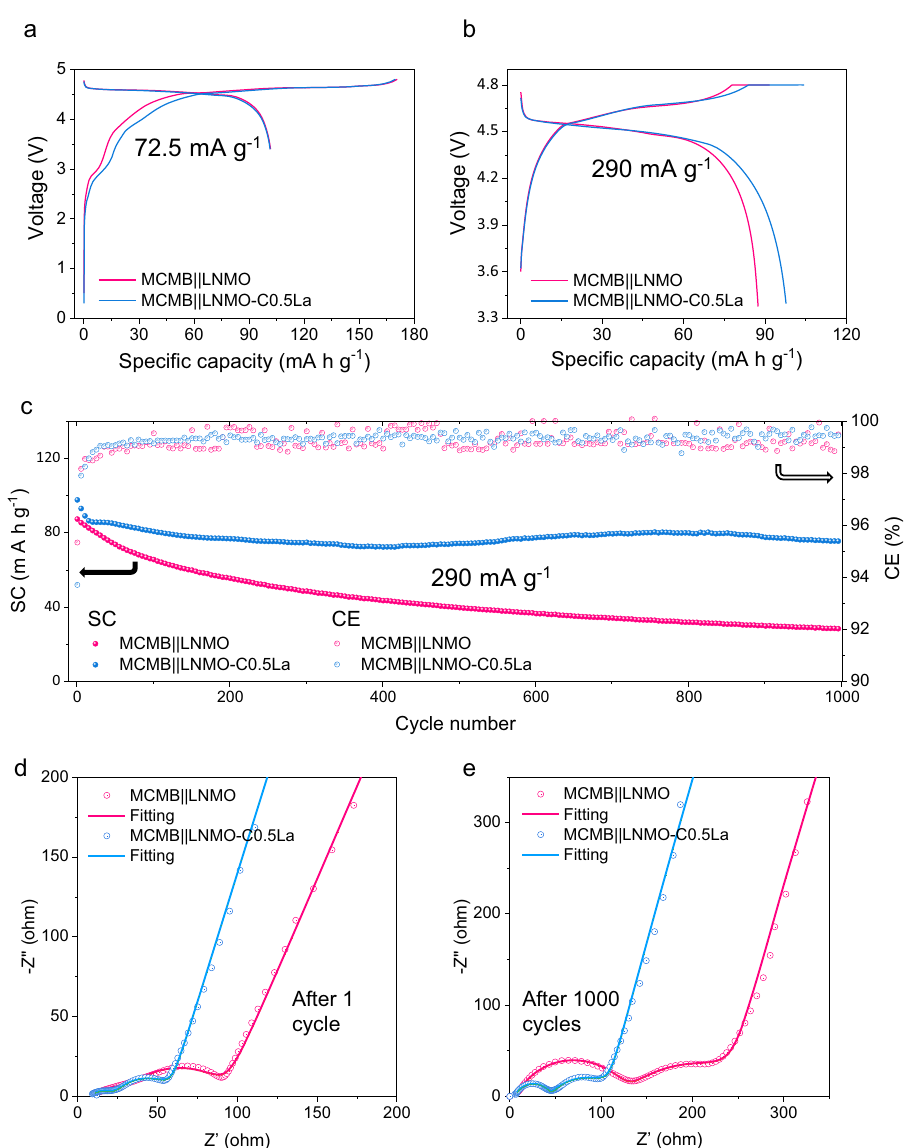
Fig. 5 Electrochemical performance of MCMB||LNMO and MCMB||LNMO-C0.5La full cells at 26 °C. a Initial charge/discharge pro fi les of the full cells at 72.5 mA g − 1 . b The charge/discharge pro fi les of the full cells at 290 mA g − 1 (following constant current charge at 290 mA g − 1 , an additional